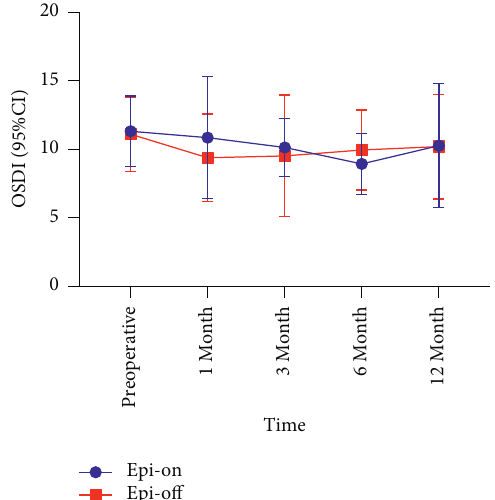
Figure 3: Comparison of the OSDI scores during the 12-month follow-up period. OSDI: Ocular surface disease index; CI: confi- dence interval.